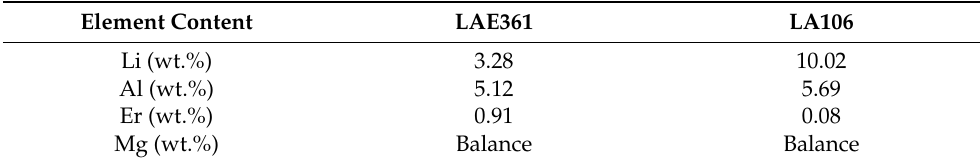
Table 1. Chemical composition of two Mg-Li alloys. Element